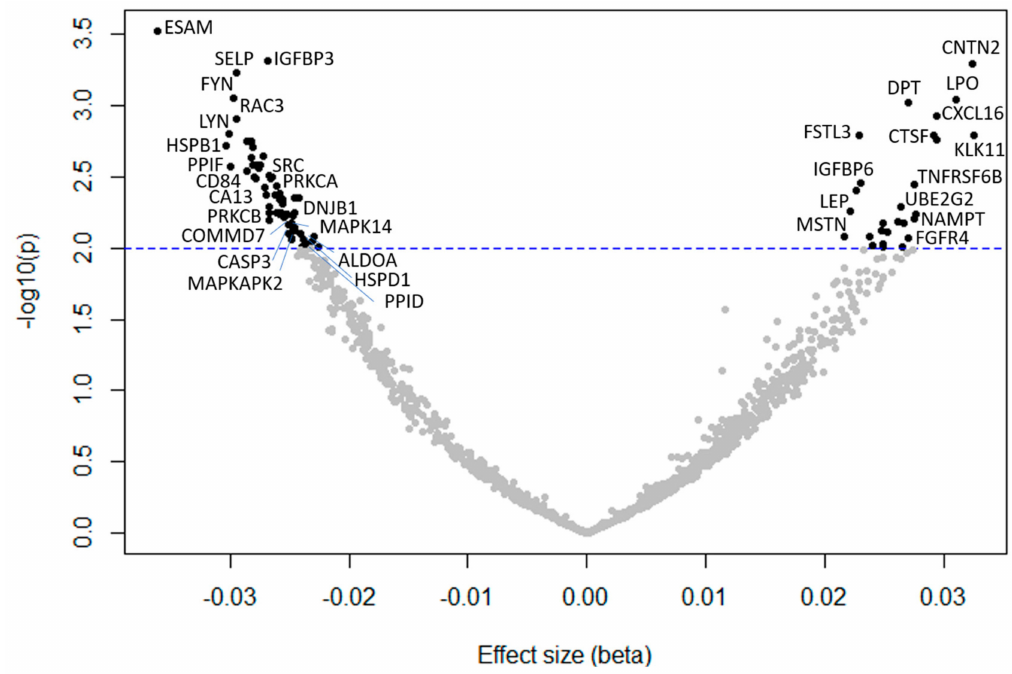
Figure 1. Volcano plot of the association between protein concentrations (gene ID in the plot) and mitochondrial oxidative capacity ( τ PCr ), adjusted for age, sex, and phosphocreatine depletion. Negative beta: proteins were positively associated with a better oxidative capacity; positive beta: proteins were associated with a poorer oxidative capacity. Table 2. Comprehensive list of 87 SOMAmers associated with τ PCr , an inverse measure of mitochondrial oxidative capacity, adjusting for age, sex, and amount of phosphocreatine depletion ( p <